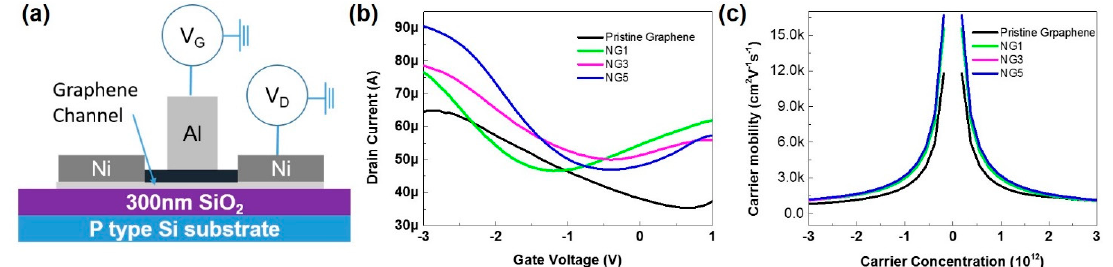
Figure 5. Transport characteristics for pristine graphene and N-doped graphene. ( a ) Schematic structure of top-gated graphene field-effect transistors (GFETs) ( b ) I d – V g curves for pristine, NG1, NG3, and NG5 FETs, with the drain voltage maintained at 0.1 V and a gate voltage sweep from − 2.5 to 1 V; and ( c ) Mobility as a function of carrier density for pristine graphene, NG1, NG3, and NG5 FETs.